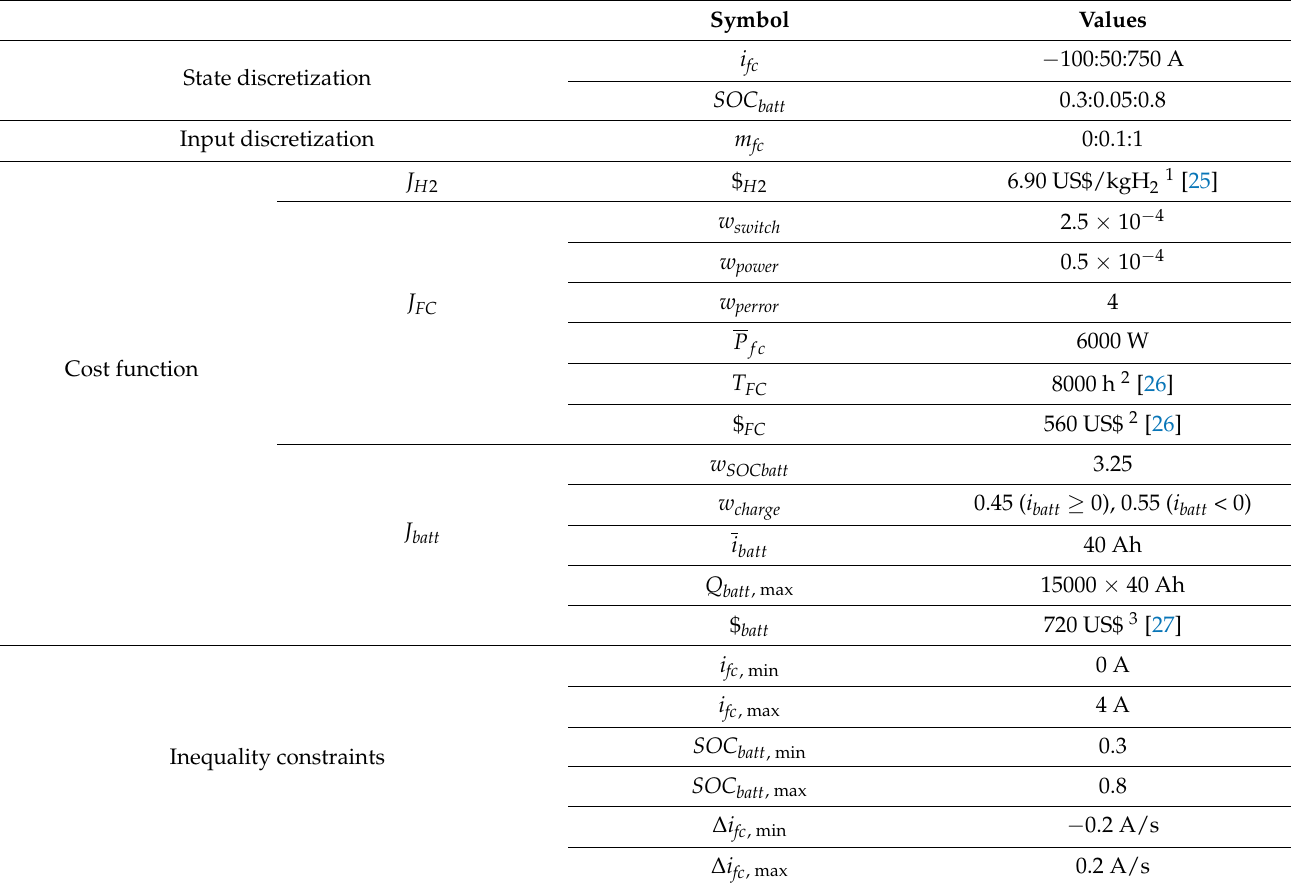
Table 2. Conditions of the dynamic programming for analyzing optimal EMS